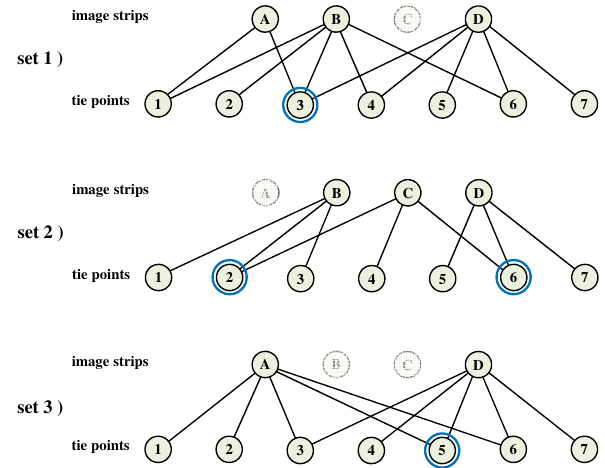
Figure 7: Example of connections of image strips via tie points; each set refers to an area marked in Figure